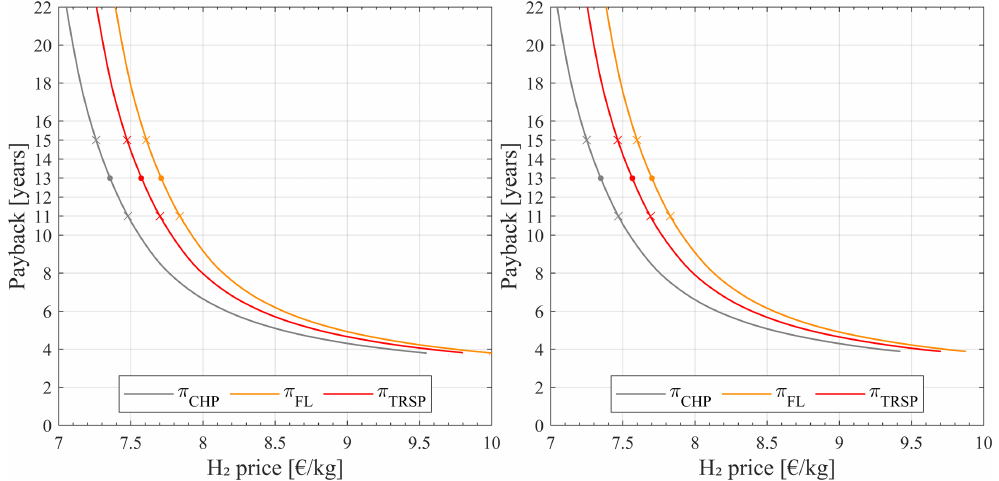
Figure 5. PPA scenarios—relation between payback period and H 2 price for each customer for scenario PPA17–20 ( left ) and PPA21 ( right